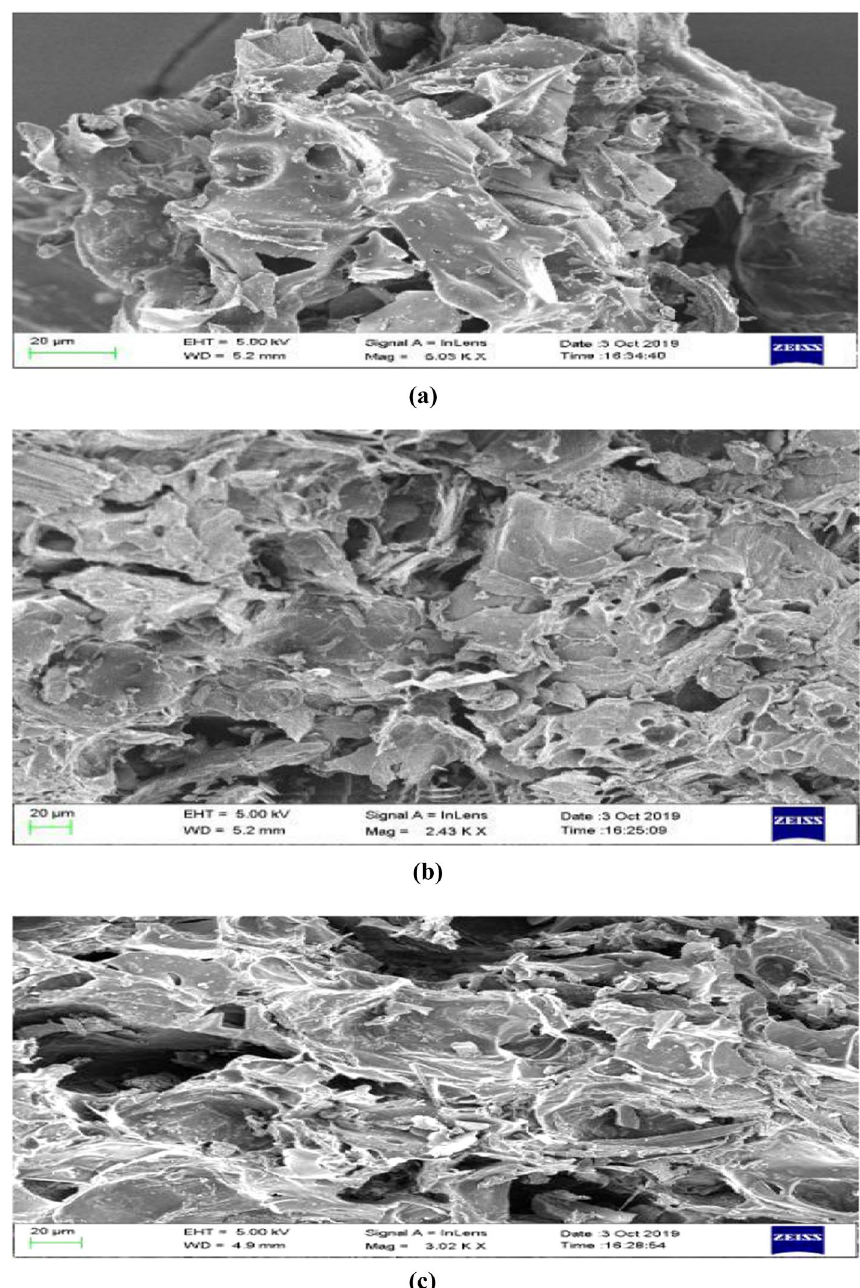
Fig. 3 a SEM image of CIABT before adsorption. b SEM image of CIABT after adsorp- tion of cyanide. c SEM image of CIABT after adsorption of